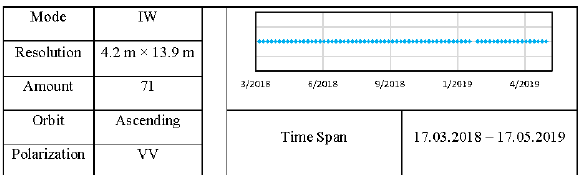
Figure 3. Sentinel-1 images used for test in open-pit mine in Cottbus, Germany (owned by LEAG).